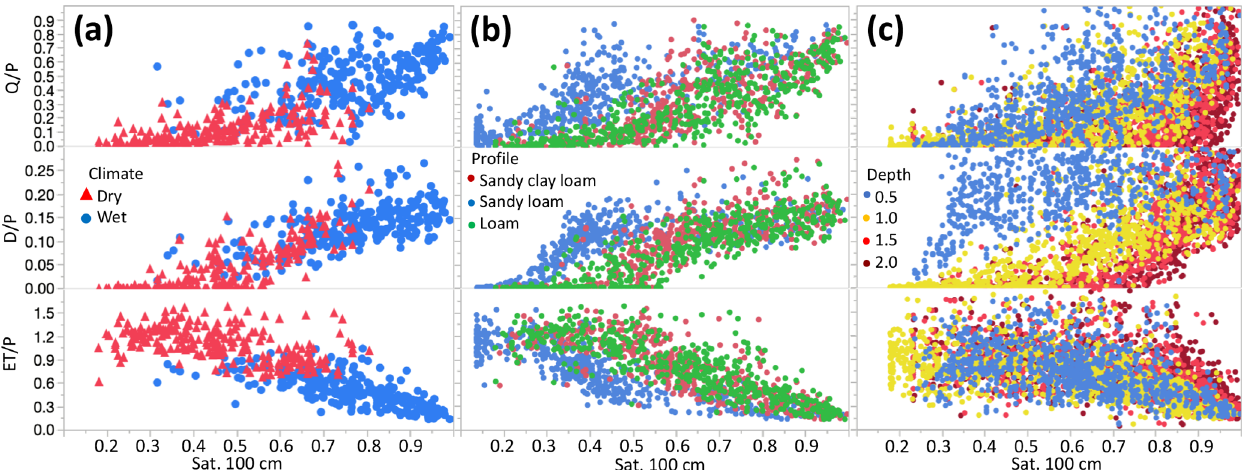
Figure 7. (a) Annual surface runoff ( Q ), deep drainage ( D ), and evapotranspiration (ET) as a fraction of annual precipitation ( P ) vs. annual mean saturation at 100cm depth (Sat 100 ) and classified by climate type on the loam profile, dry sites P/ PET < = 1, wet P/ PET > 1. (b) The same variables displayed in (a) but classified by soil texture on three different soil profiles. (c) The same variables in A but classified by root zone depth on four different profiles of differing root zone depth. All simulations use historical